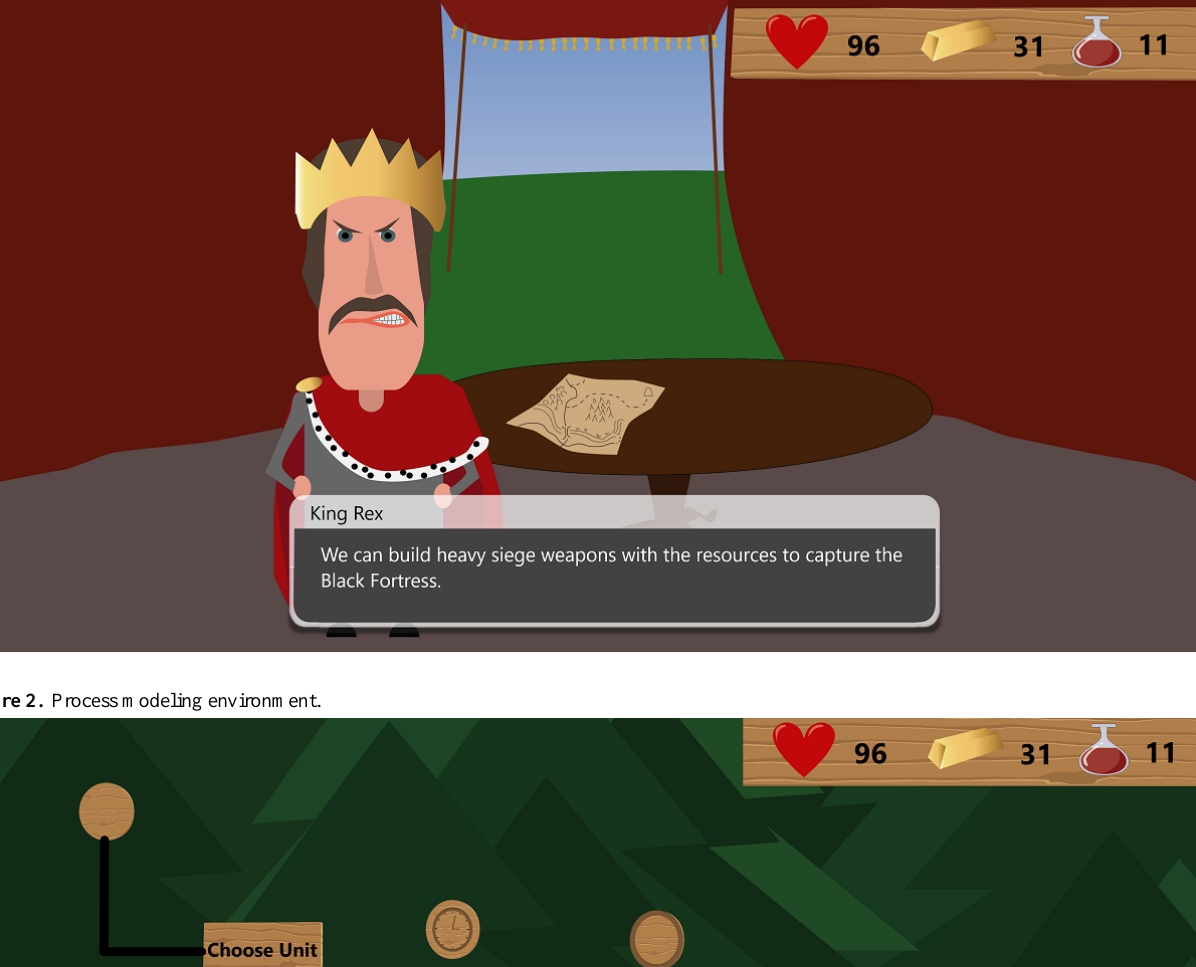
Figure 1. Storytelling of the serious game.